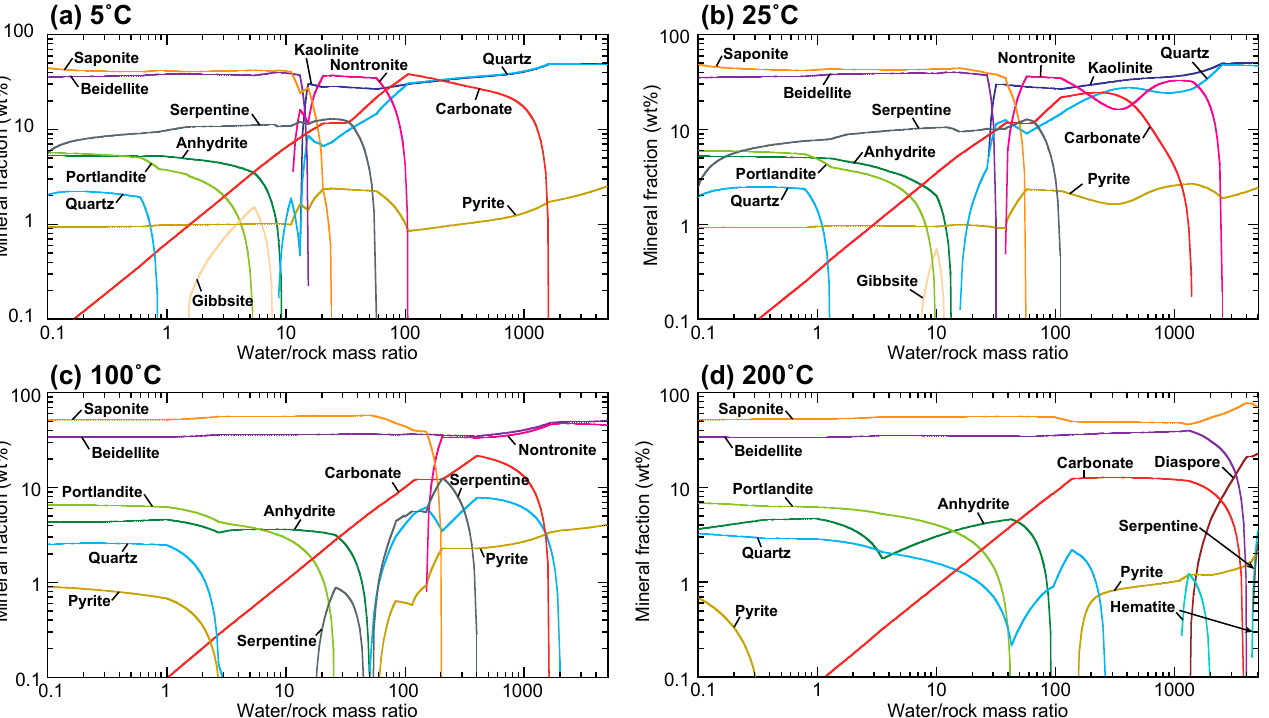
Figure 3. Secondary mineral assemblages when rock reacted with H 2 -bearing initial fluid (Case II-SG) at temperatures of ( a ) 5 °C; ( b ) 25 °C; ( c ) 100 °C; and ( d ) 200 °C. Gas fugacities were not fixed during the water–rock reactions. The results are almost completely the same as those obtained from O 2 -bearing initial fluid.